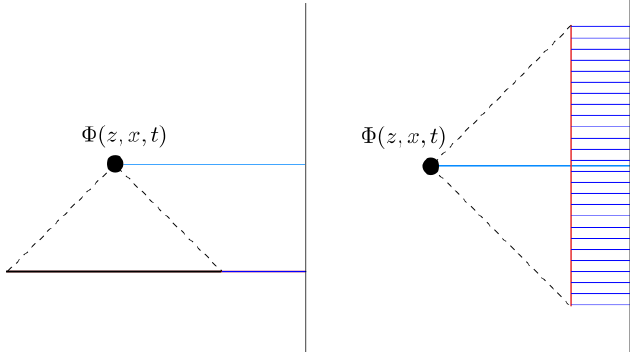
Figure 1 . A bulk local operator expressed using a retarded (left)/spacelike (right) Green’s function. The green line denotes the gravitational dressing of the operator. This operator, along with its smearing can be represented in terms of initial data for the matter part (red smearing) which itself is graviationally dressed